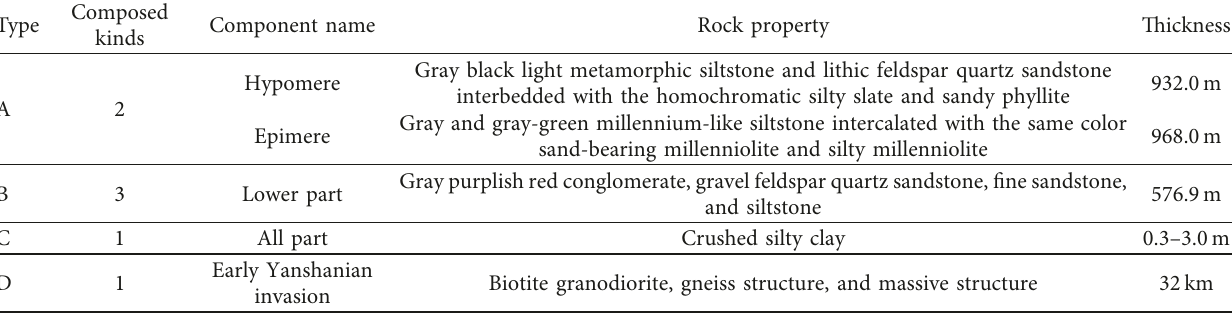
Table 1: Stratigraphic rock